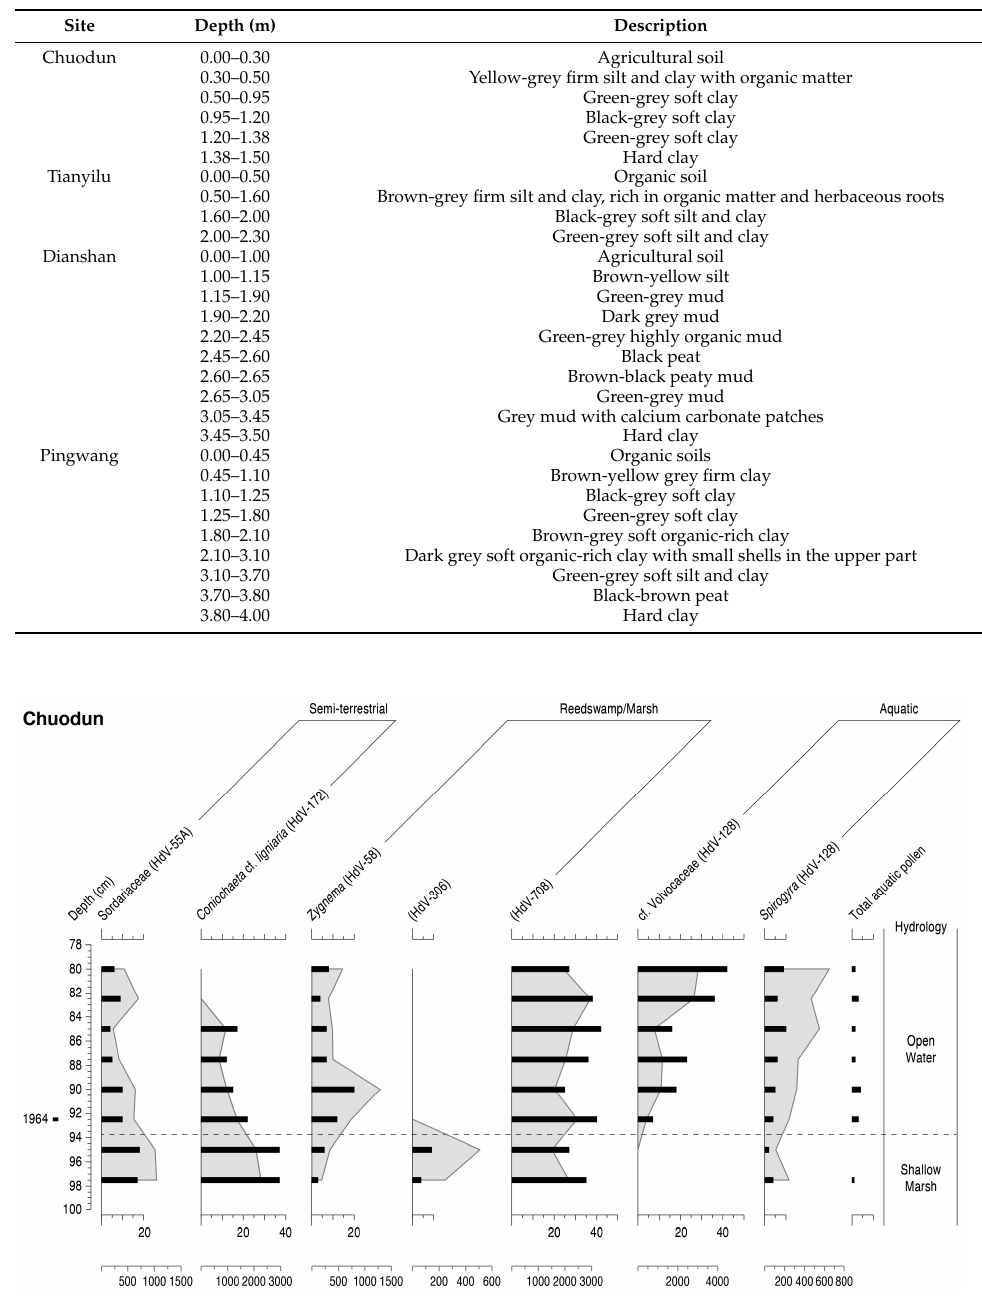
Figure 2. Frequencies of selected NPP taxa (histogram bars calculated as % total NPPs) from Chuodun. A combined aquatic pollen curve is also shown, calculated as percentages of total land pollen. Pollen concentration values for the NPPs are shown as shaded curves (numbers of grains per cc. on the secondary x-axis ). 4.2. Tianyilu Tianyilu lies 600 m east of Siqian village, to the east of Lake Dianshan at 31°11 ′ 54 ″ N; 121°6 ′ 40 ″ E with a ground surface altitude of 1.9 m YSD. The selected taxa microfossil diagram is presented as Figure 3. The site supported shallow marsh wetland habitats, as shown by the high frequencies of taxa indicative of wet surface marsh or shallow reedswamp, until 4000 cal. BP when the curves for fully aquatic taxa increase sharply, particularly Volvocaceae, Spirogyra and Mougeotia . Coniochaeta cf. ligniaria and HdV-708 are especially reduced, while Sordariaceae percentages decline more gradually, this general decomposer of plant material remained present in the locality. Pollen of floating and emergent aquatic plants occurs in low frequencies in this open water phase of the core, including Myriophyllum and Nelumbo , while Typha percentages are low to moder- ate. The total aquatic pollen curve comprises mainly Typha . The change in hydrological regime with significantly increased water depth at 4000 cal. BP was quite swift and rep- resents one or more major fluvial flooding events. Concentration rates mirror the per- centage changes well, and changes in taxa frequencies reflect changes in proportions in the assemblage, notably the switch from Coniochaeta to Volvocaceae as water levels deepened significantly. The age of 4000 cal. BP is significant in that it falls within a phase of climatic deterioration that has considerable evidence for flooding in most parts of the Yangtze catchment, as discussed below.